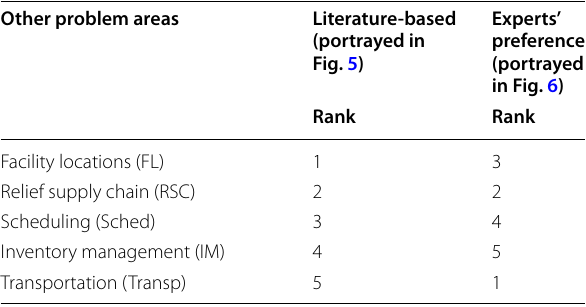
Table 5 Comparison of influential priorities between literature and